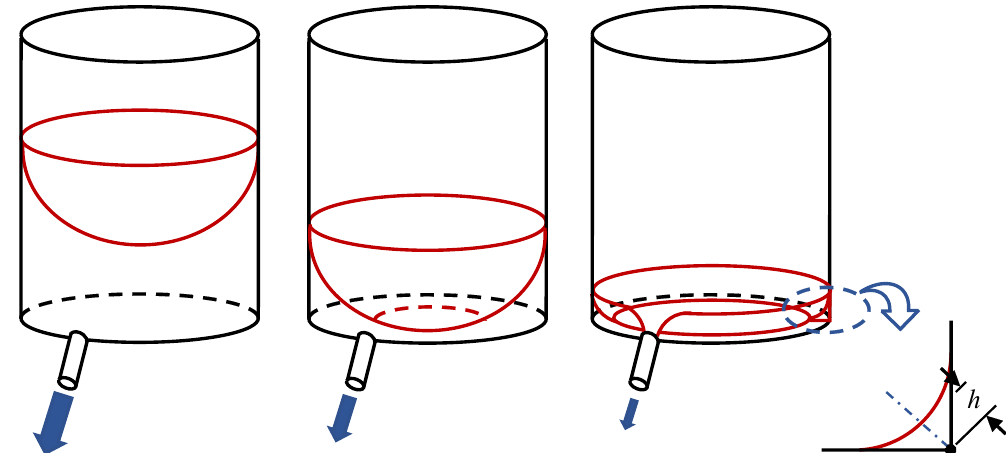
Figure 1. Simple example of capillary draining in a zero-gravity environment. The late-stage draining condition ( right ) yields a thin visco-capillary flow that is approximately linear, with approximately 2D-Cartesian cross-section sketched ( far right ).